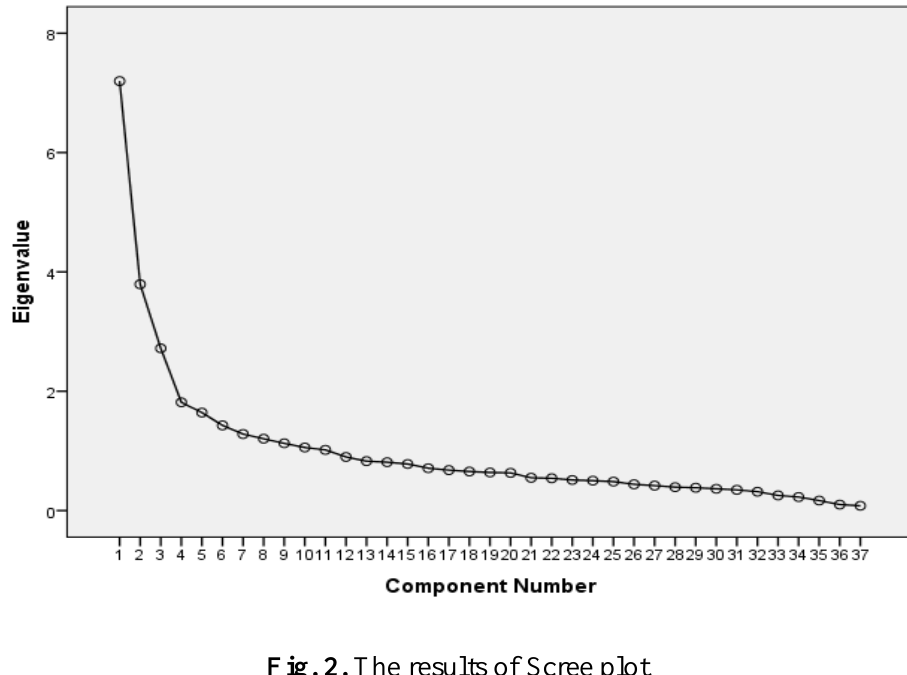
Fig. 2. The results of Scree plot